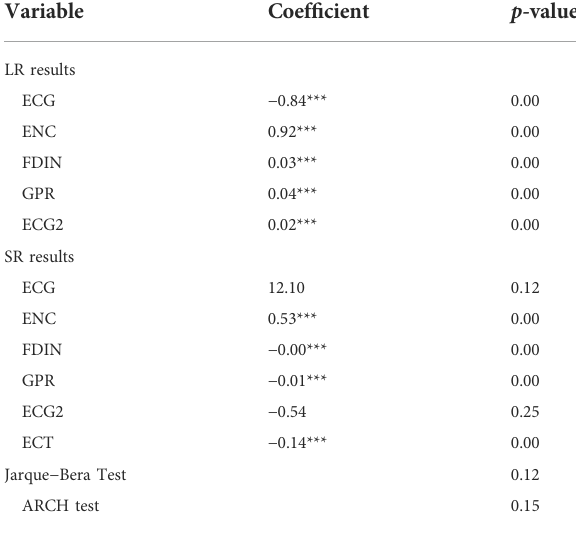
TABLE 5 Findings from PMG − ARDL for developed